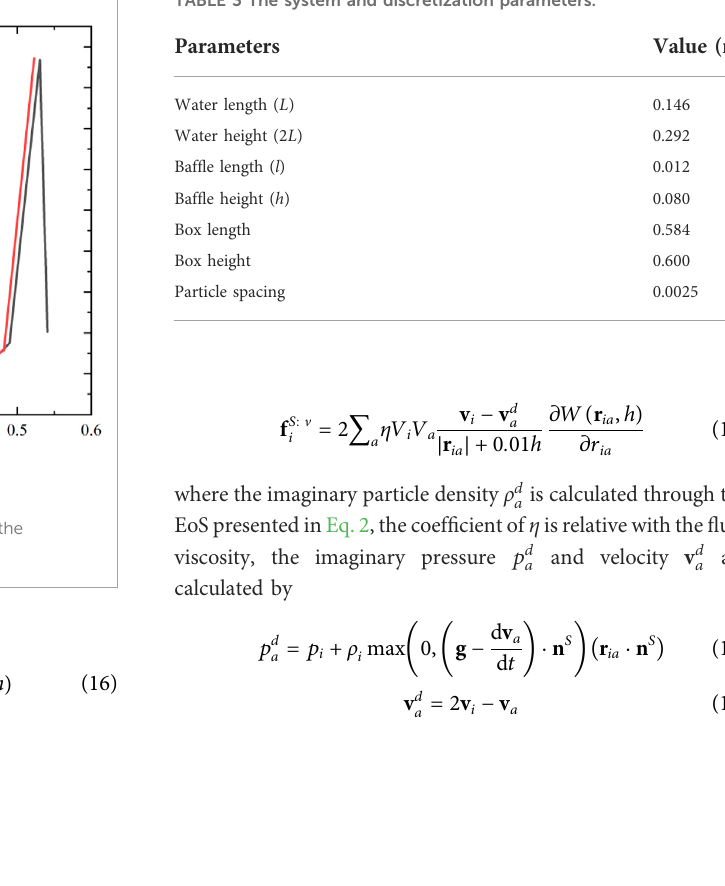
TABLE 3 The system and discretization